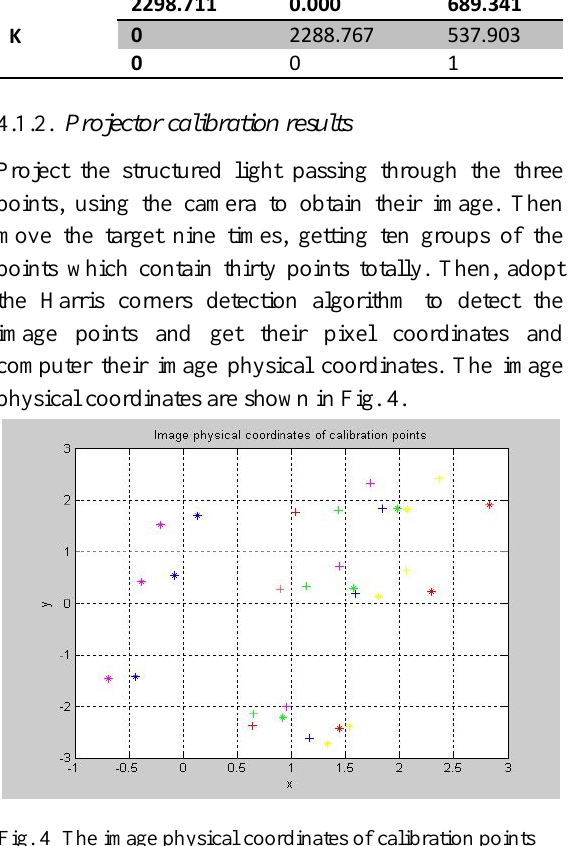
Fig. 4 The image physical coordinates of calibration